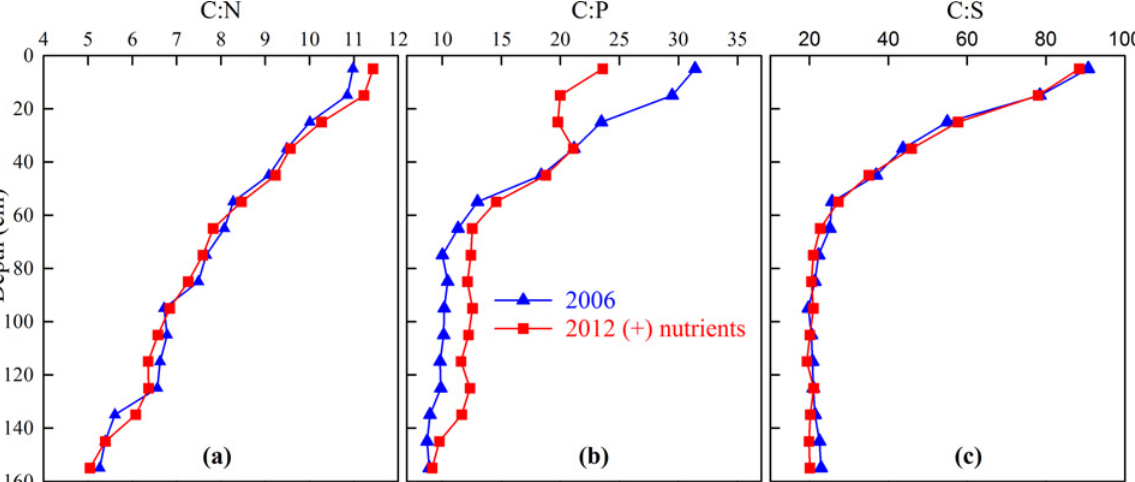
( − ) nutrients (+) nutrients